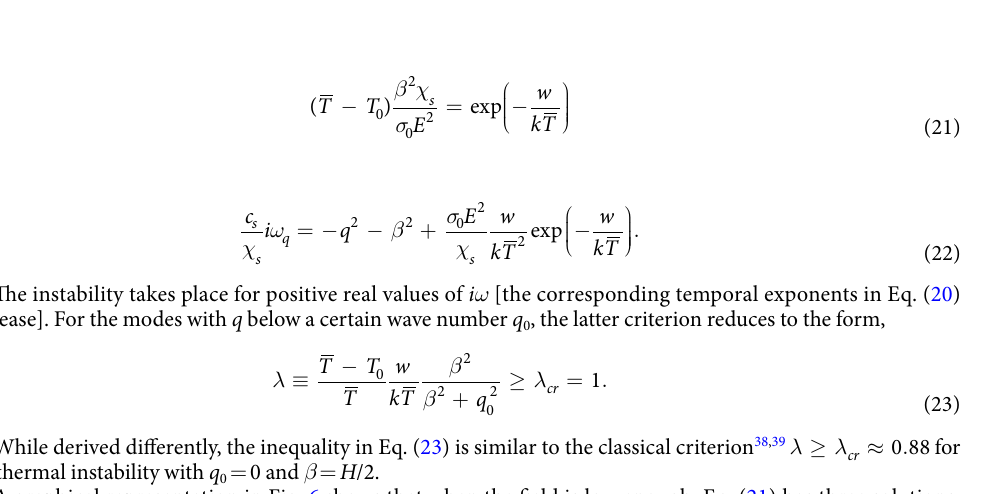
Figure 5. A sketch of a semiconductor layer (transparent) between two metal electrodes (grey) of thickness L each. The bottom view shows a hot spot caused by the runaway instability. χ s and χ e are respectively the thermal conductivities of the semiconductor and electrode materials, σ is the semiconductor conductivity, E is the electric field, and T 0 is the temperature on the external electrode